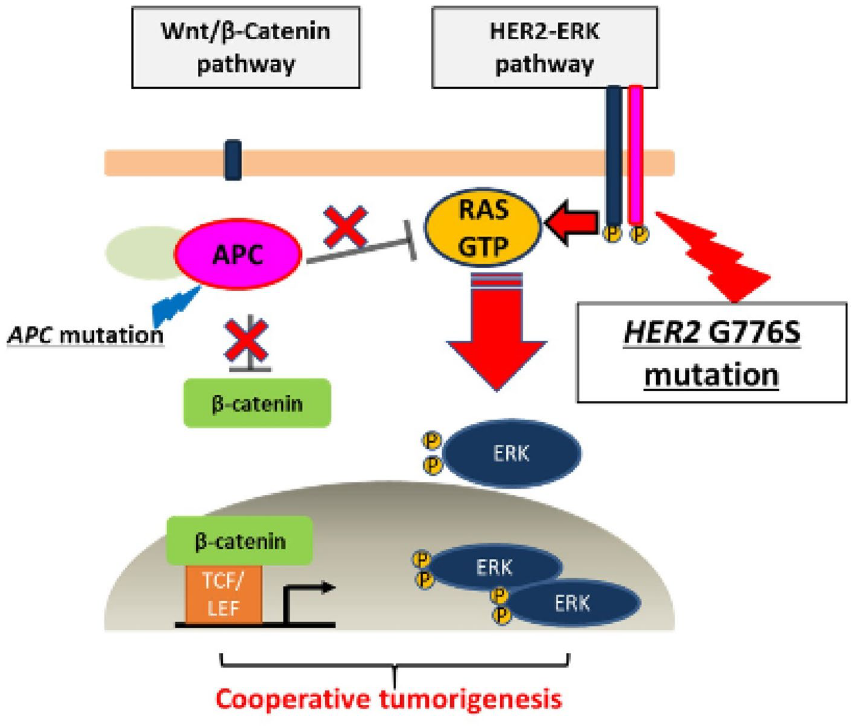
Figure 7. Schema of the relationship between HER2 mutations and APC mutations in colorectal cancer cells. HER2 G776S is a mutation that increases HER2 kinase activity, although the activity is weak. APC loss-of- function increases Wnt/β-catenin pathway activation but also increases the amount of RAS-GTP, which helps the HER2 G776S mutation to activate the HER2-ERK